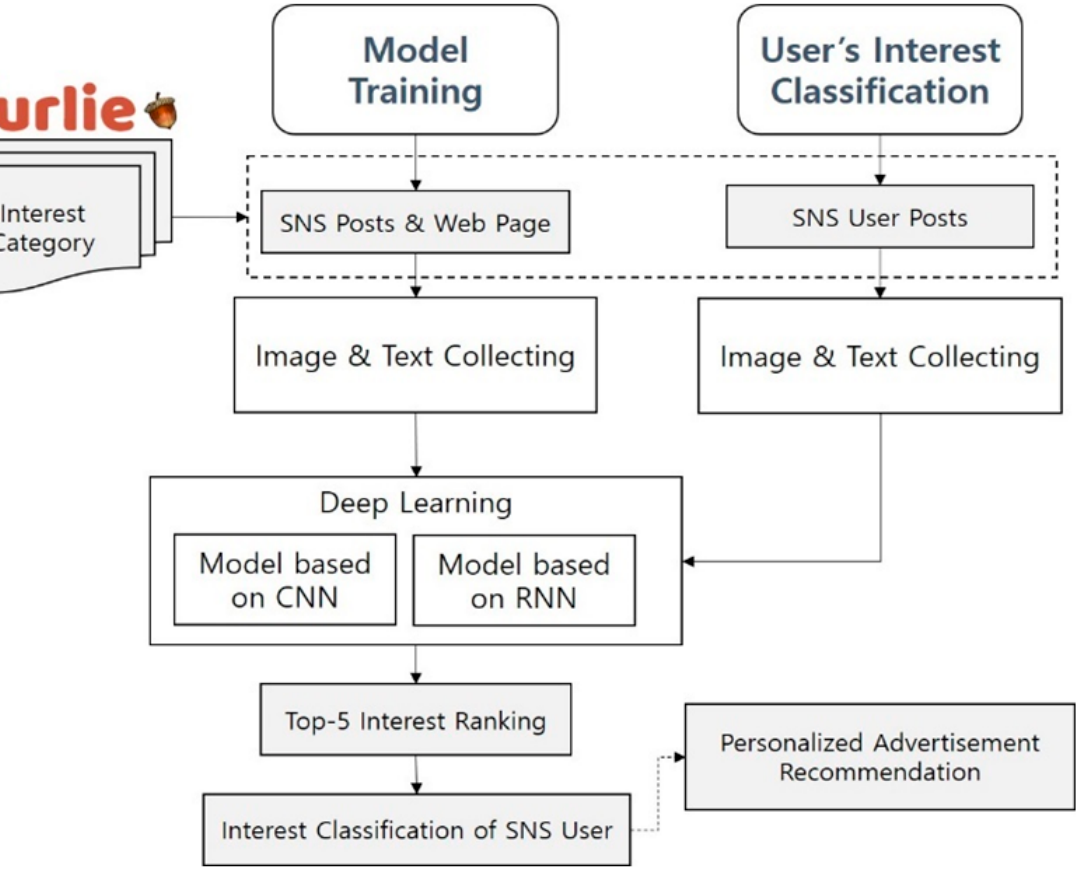
Figure 1. Architecture of category classification system for personalized ads.